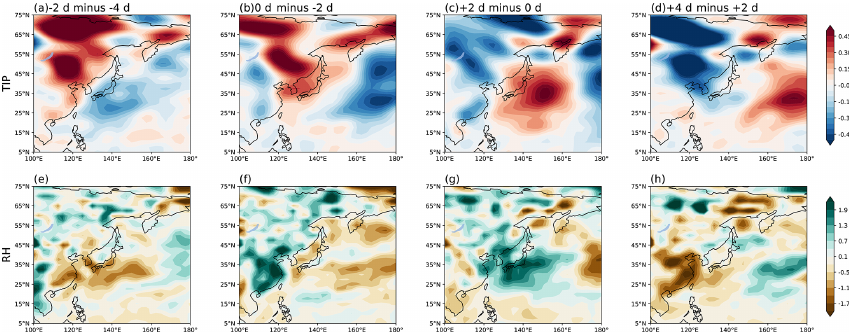
Figure 11. Composite anomalies of (a–d) TIP variations (unit: K) and (e–h) RH variations (unit: %) from − 4 to 4d related to Type3 severe HD EC